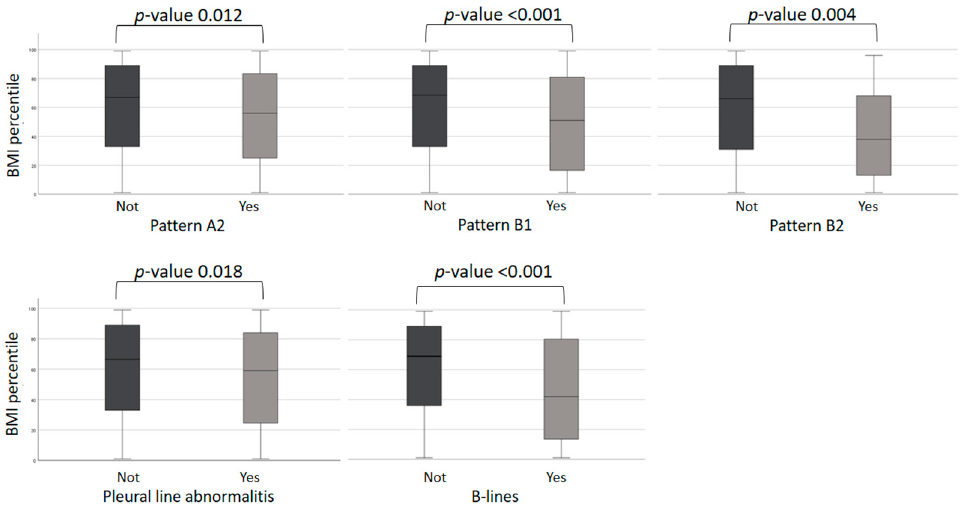
Figure 4. Association between lung ultrasound artifacts and Body Mass Index. Data not statistically significant have not been reported (subpleural consolidation and Pattern C).